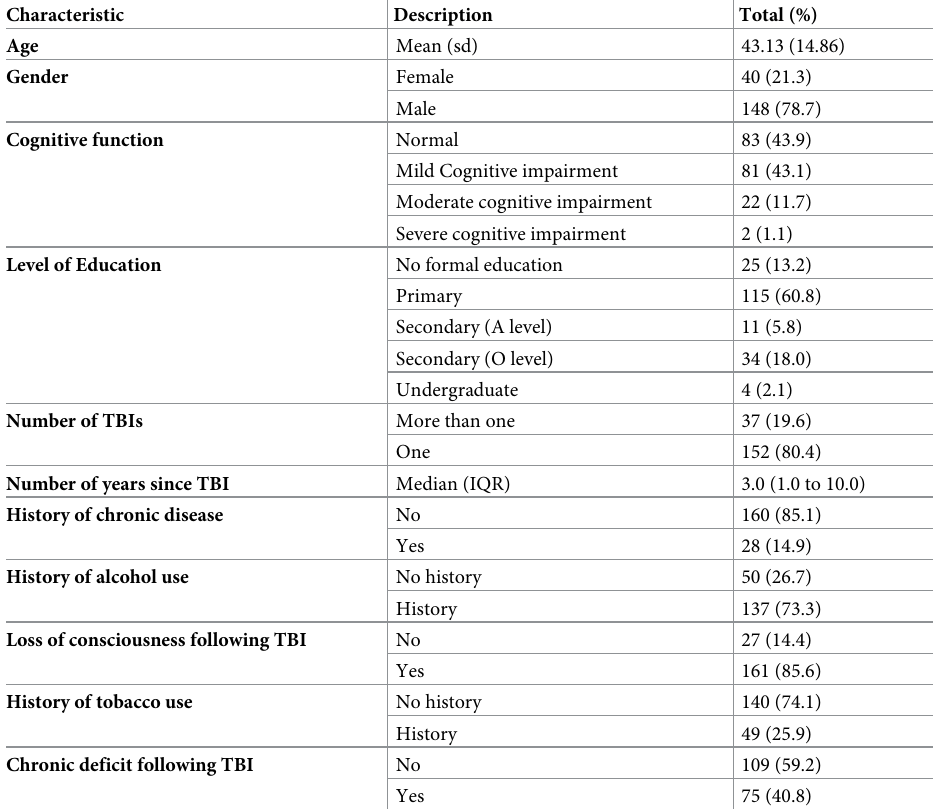
Table 1. Baseline characteristics of the study